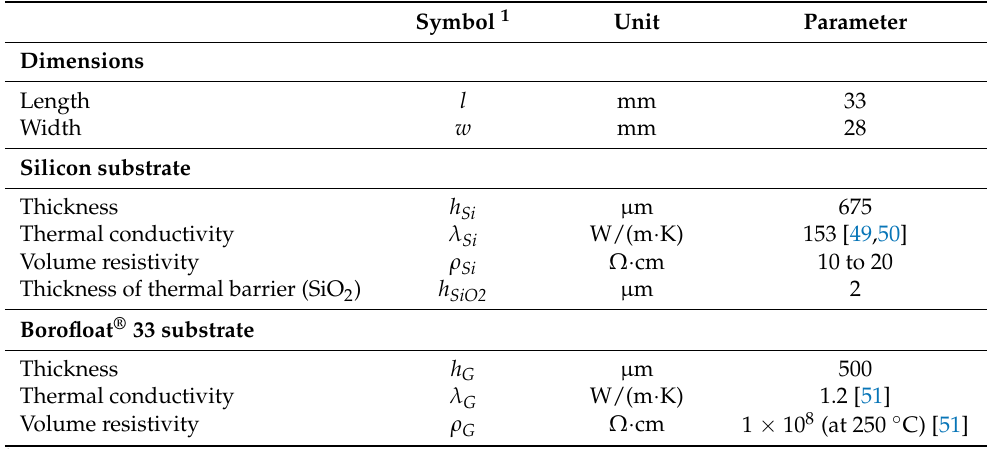
Table 2. Material and design parameters of the bond substrates.